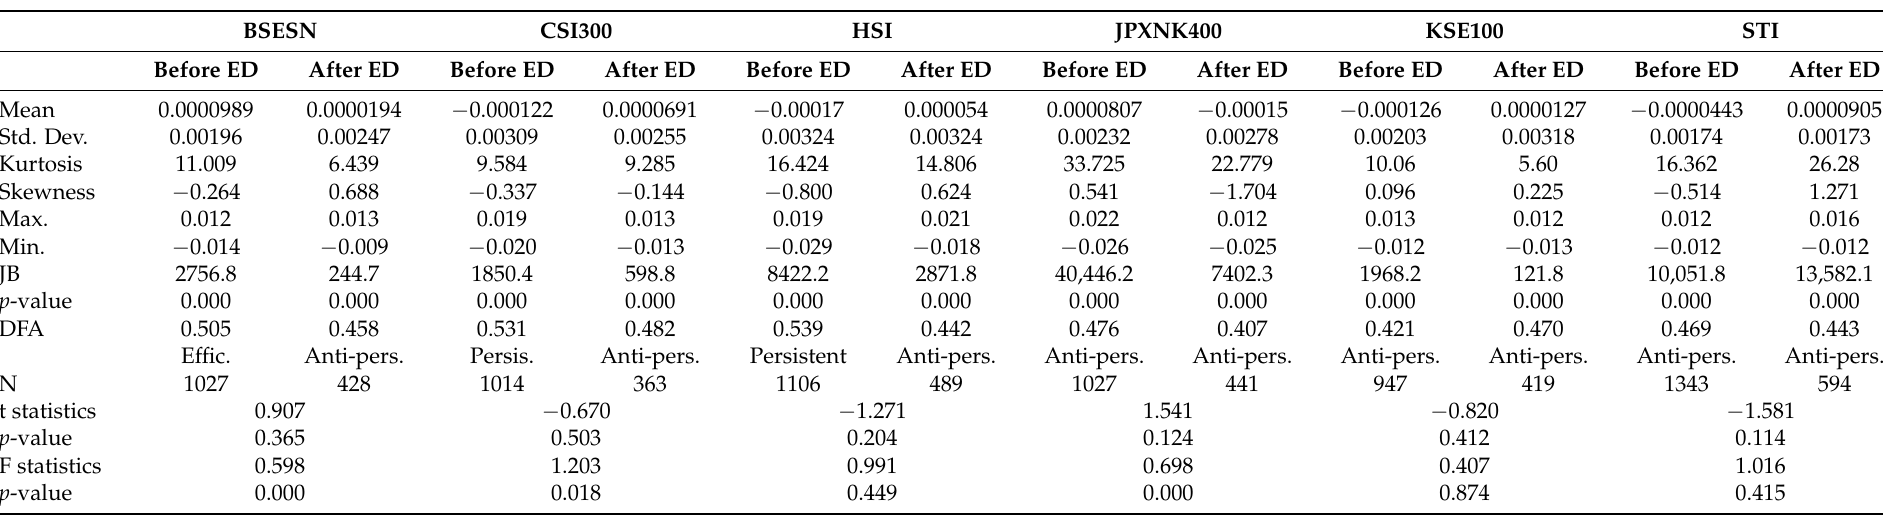
Table 2. Descriptive statistics, JB test for normality, DFA results for long-range dependence, T-test and F-test for equal mean and